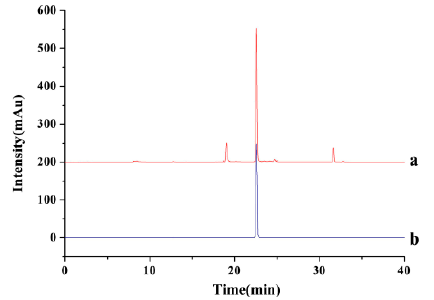
Figure 6. HPLC-DAD chromatograms of recovery sample from S. sinensis ( a ) and [C 6 mim]BF 4 standard ( b ). Table 3. Results of recovery of two biflavonoids and IL with di ff erent organic solvents (%) (n = 3).